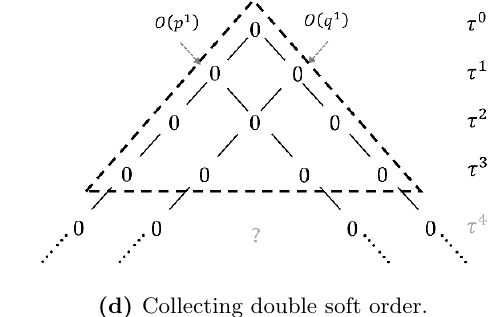
Figure 5. A special case of (cid:12)gure 4 for DBI amplitudes, with vanishing single soft theorem and (cid:21) = 1. Compared with (cid:12)gure 3, more expansion terms can be derived, hence higher order double soft